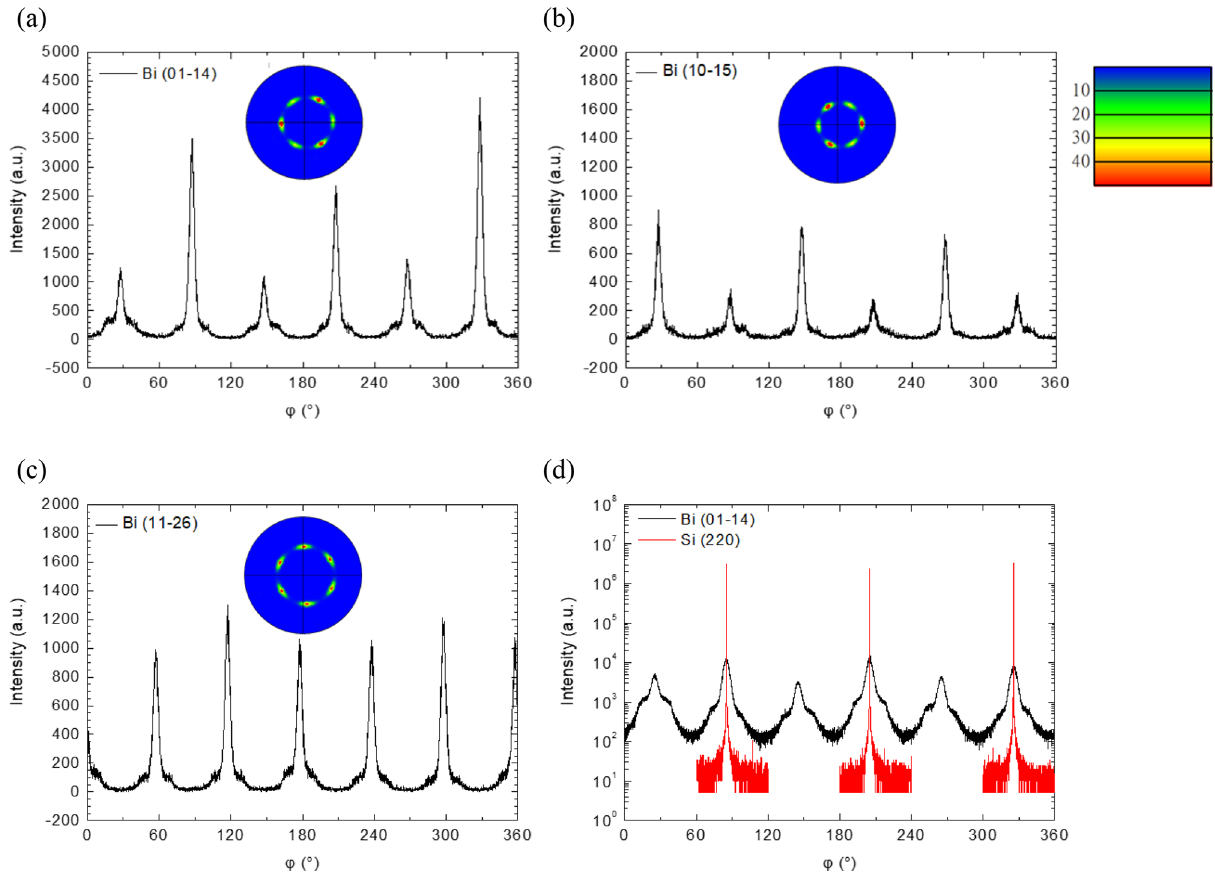
Figure 3. HRXRD φ scans of asymmetric ( a ) Bi (01-14), ( b ) Bi (10-15), ( c ) Bi (11-26) planes. The EBSD pole figures of the three Bi planes are shown as the inset in their panels with the intensity color bar shown in the right top of ( b ). ( d ) HRXRD φ scans of Si (220) and Bi (01–14) planes in logarithmic